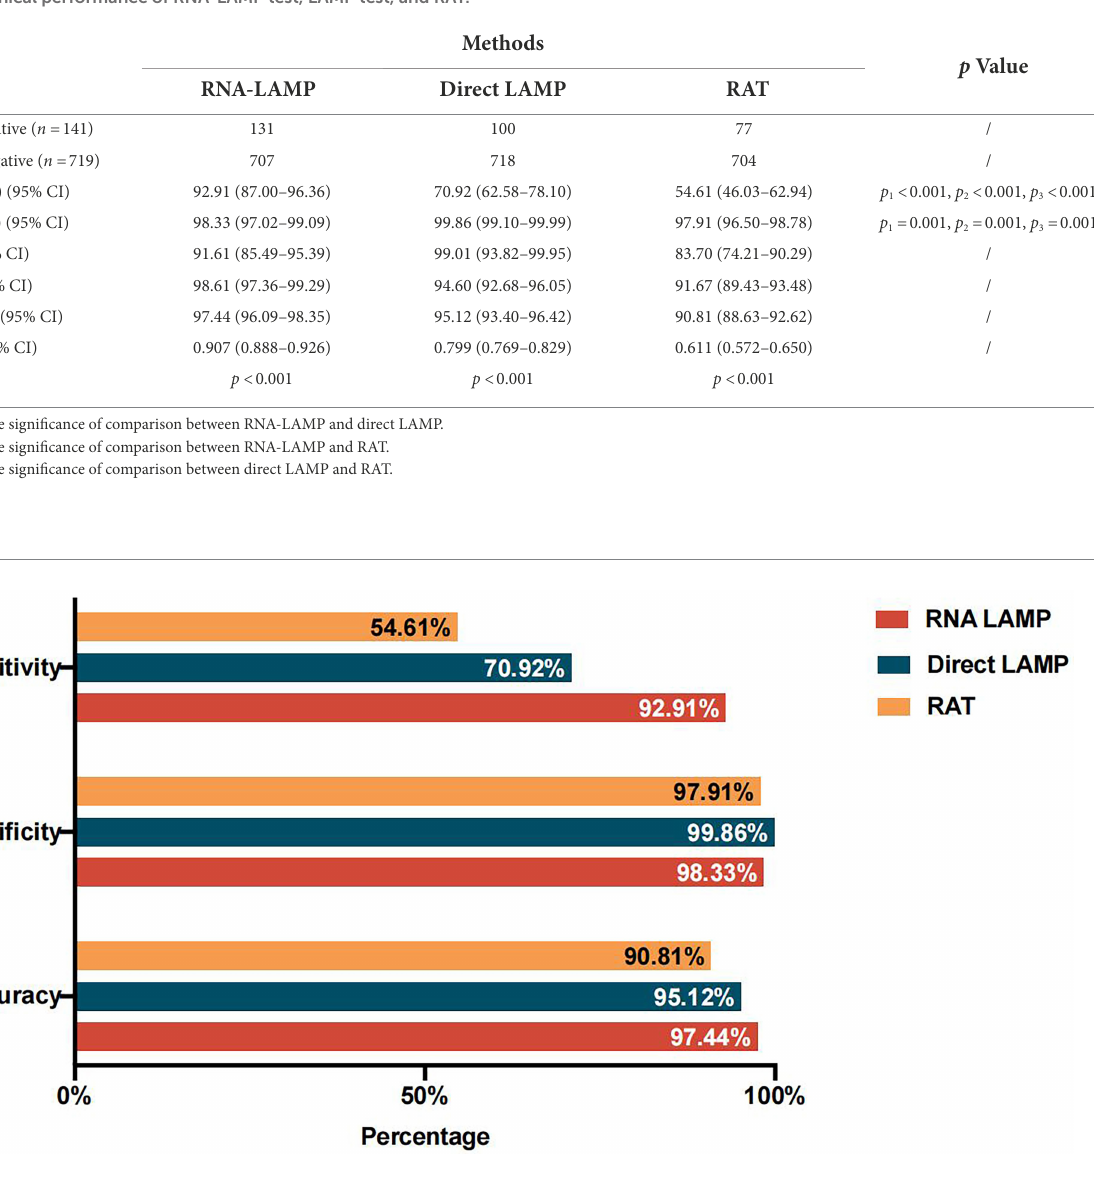
TABLE 2 Clinical performance of RNA-LAMP test, LAMP test, and RAT.